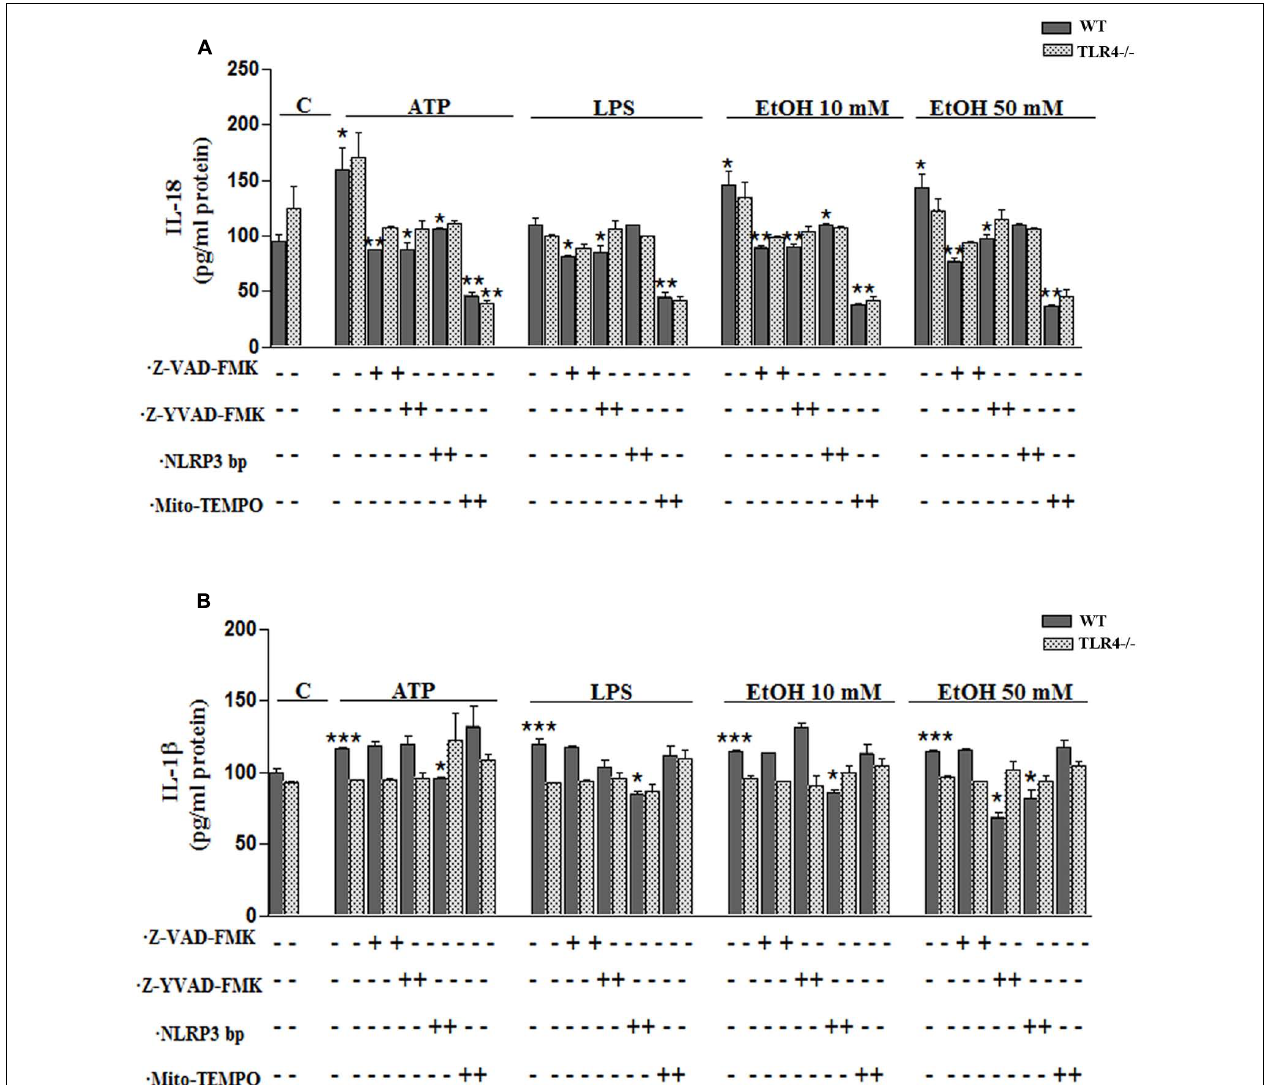
FIGURE 5 | Ethanol enhances the production of IL-18 and IL-1 β inWT astroglial cells. (A,B) Graphs represent the levels of IL-18 (A) and IL-1 β (B) measured in the supernatant medium of theWT andTLR4-KO astrocytes treated with ATP, LPS or ethanol (10 and 50 mM) for 24 h. Incubation with Z-YVAD-FMK, Z-VAD-FMK, the NLRP3 blocking peptide or Mito-TEMPO, along with the different treatments, reduces, or even abolishes, the